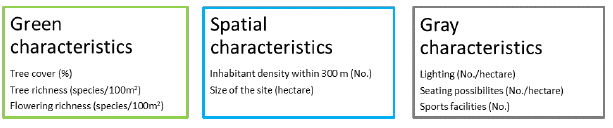
Fig. 2 . Measured urban green space (UGS) characteristics of three structural dimensions (green, spatial, and gray) in 18 urban parks and 18 green